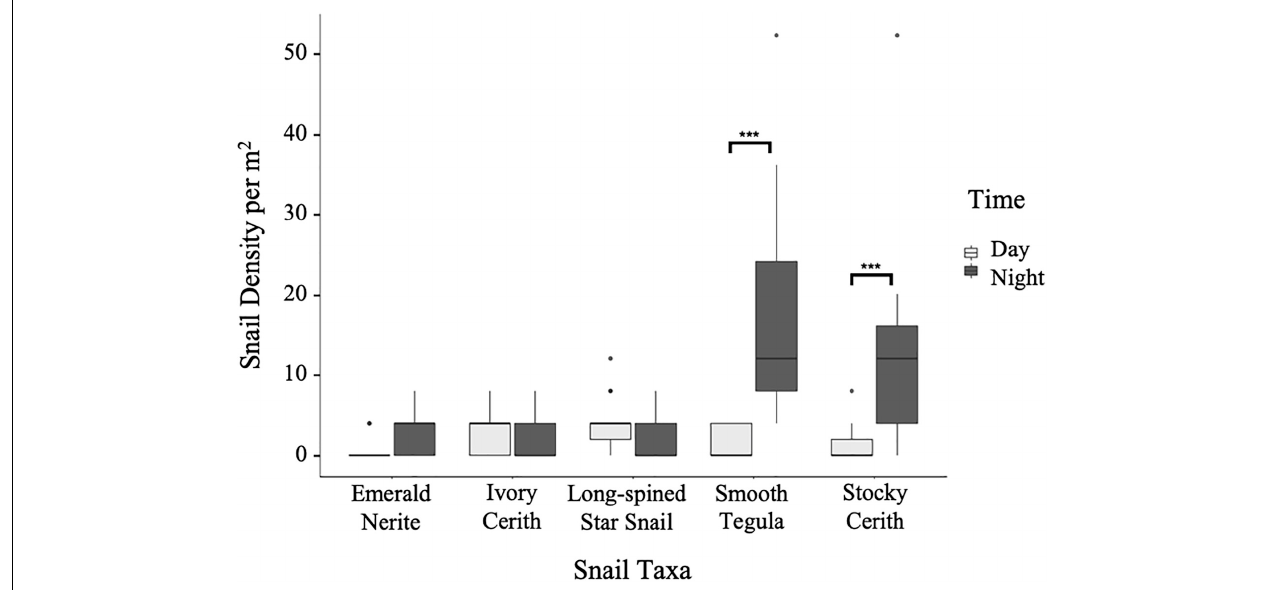
FIGURE 2 | Comparison between day and night densities of five common Belize snails ( Cerithium litteratum– stocky cerith, Tegula fasciata– smooth tegula, Smaragdia viridis– emerald nerite, Cerithium eburneum– ivory cerith, and Lithopoma phoebium– long-spined star snail). Three of the five common Belize snails (i.e., smooth tegula, stocky cerith, and emerald nerite) were found at higher densities during the night, while two (i.e., ivory cerith and long-spined star snail) were found in higher densities during the day. Significant p -values within each species comparing daytime and nighttime counts were calculated through a generalized linear model for Poisson and a post hoc estimated marginal means pairwise analysis *** p ≤